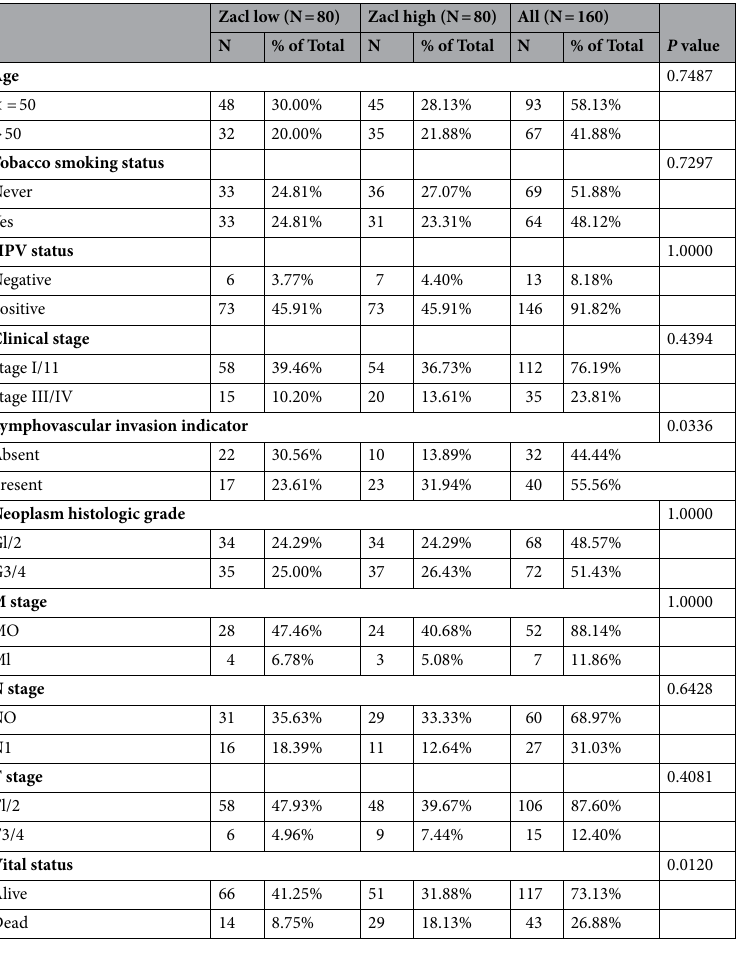
Table 1. Characteristics associated with Zac1 mRNA expression in TCGA-CESC. P-value < 0.05 indicates statistical significance by a Chi-square